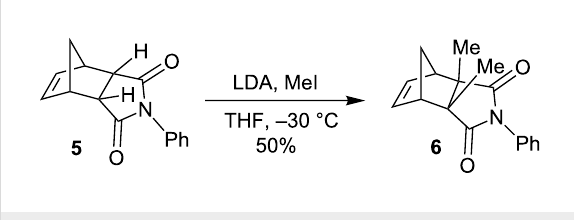
Scheme 2: Garratts work on alkylation of norbornene with retention of configuration.